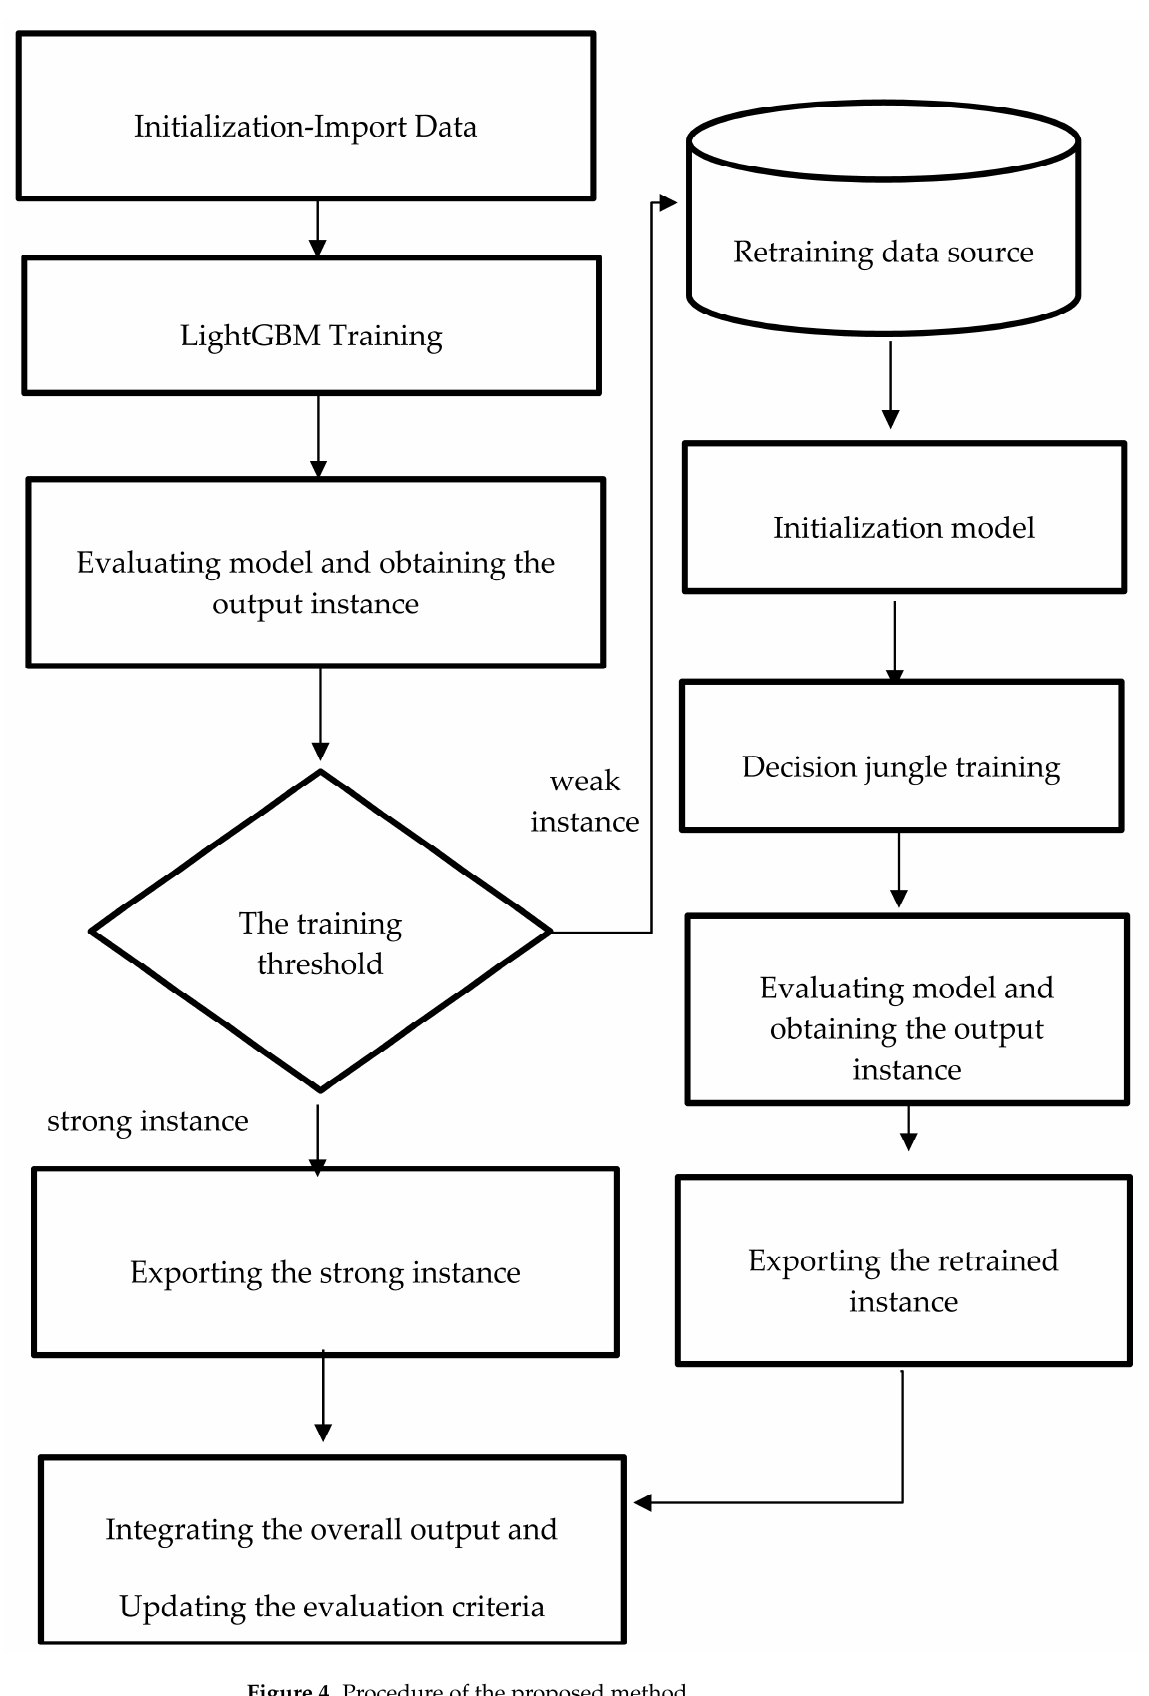
Figure 4. Procedure of the proposed method.